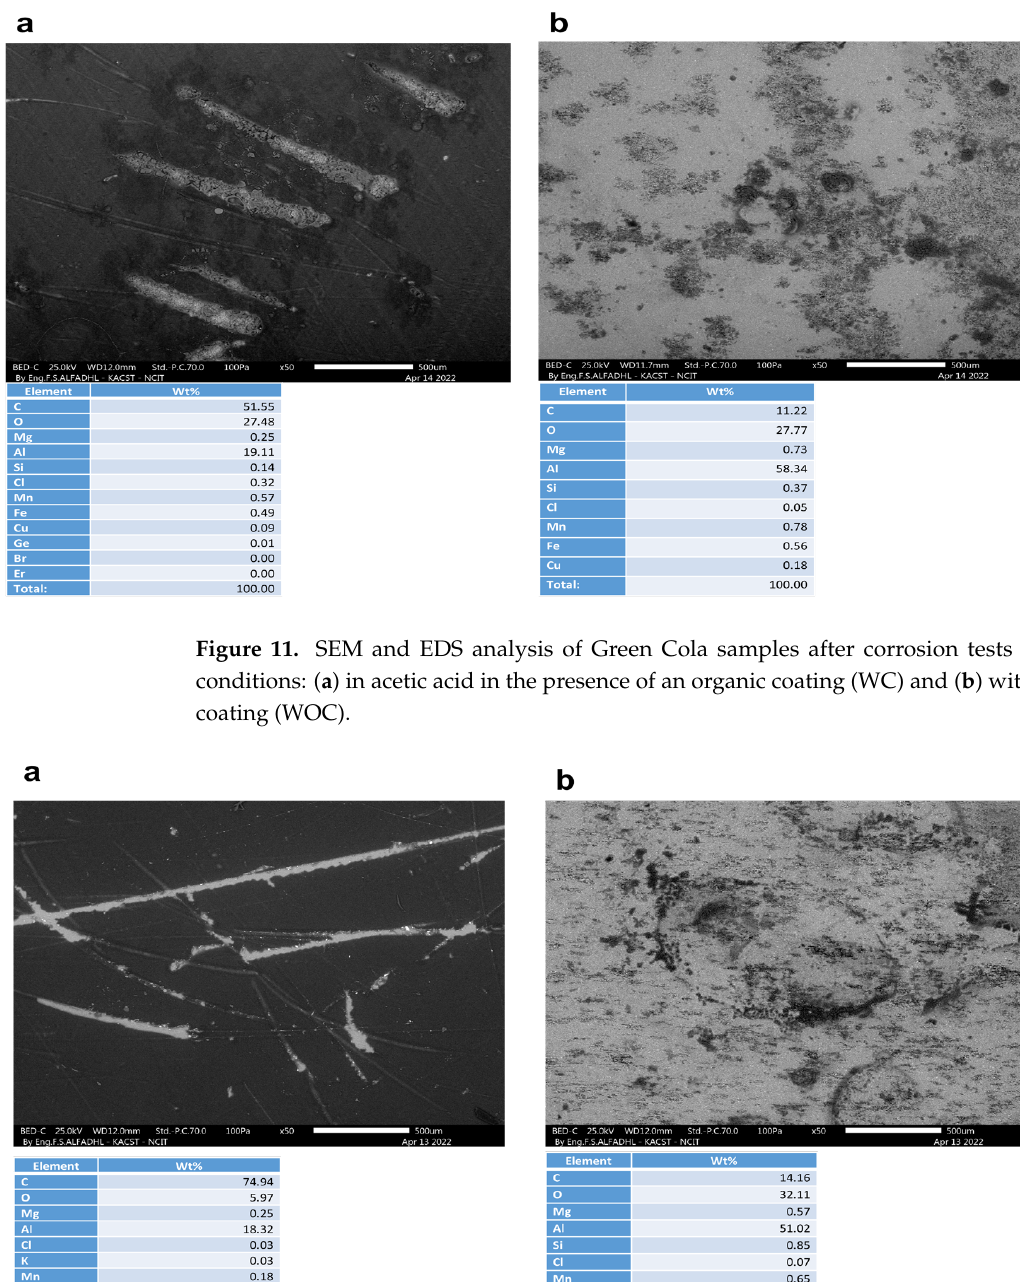
Figure 10. SEM and EDS analysis of Green Cola samples after corrosion tests under different condi- tions: ( a ) main solution in the presence of an organic coating (WC) and ( b ) without an organic coat- ing (WOC).